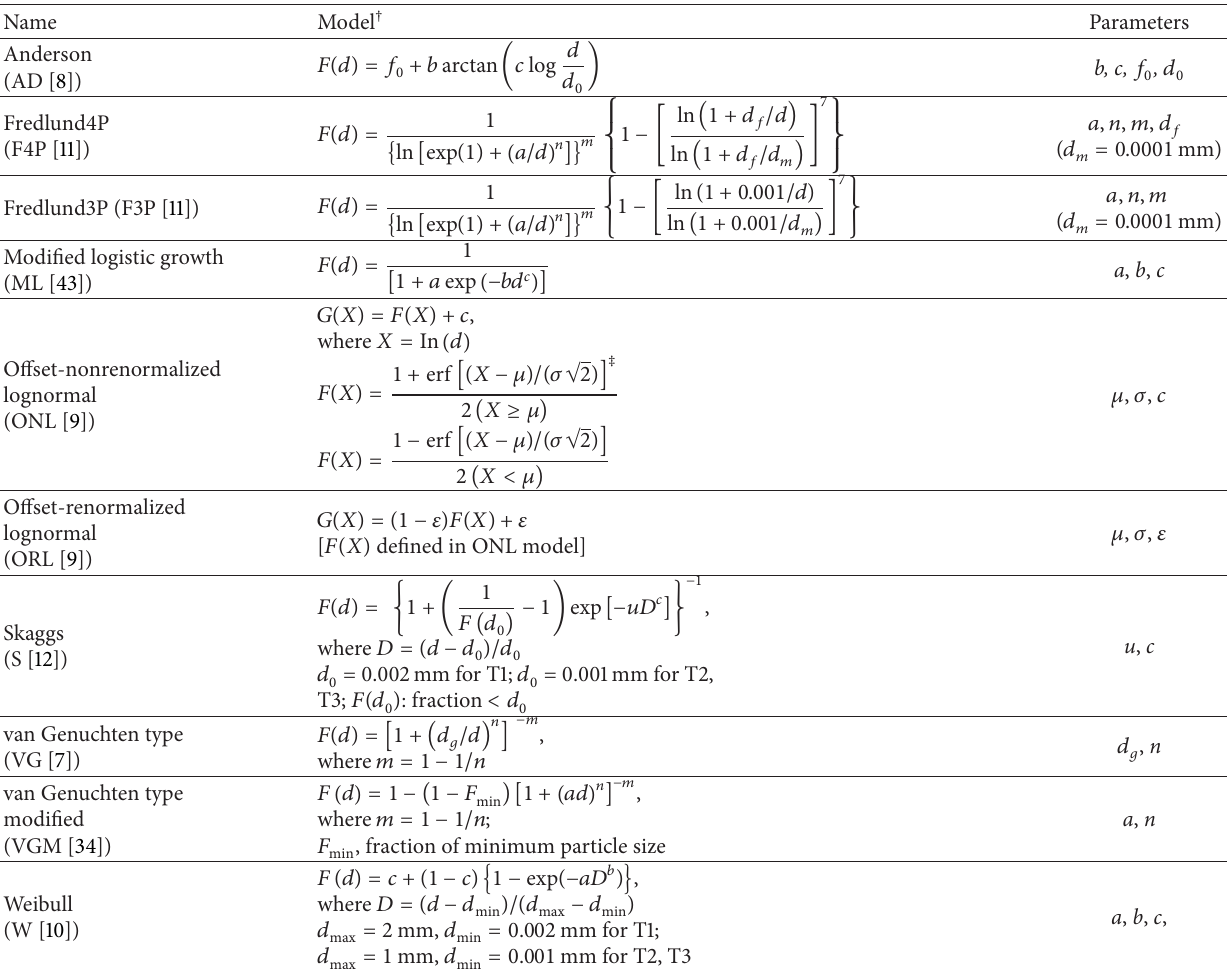
Table 2: Particle-size distribution